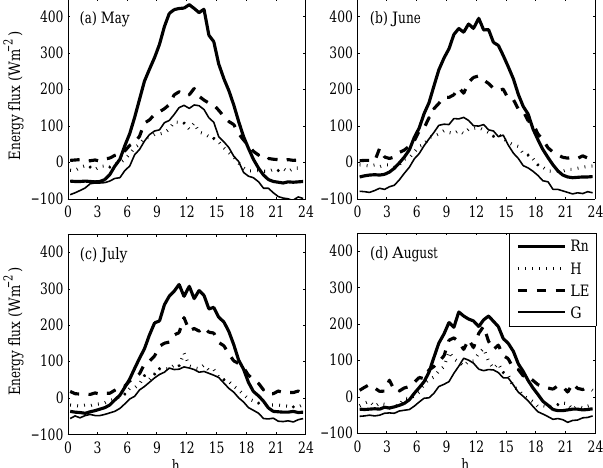
Figure 5. Monthly average diurnal courses of the energy balance components. The time shown on the x axis is local winter time (UTC +